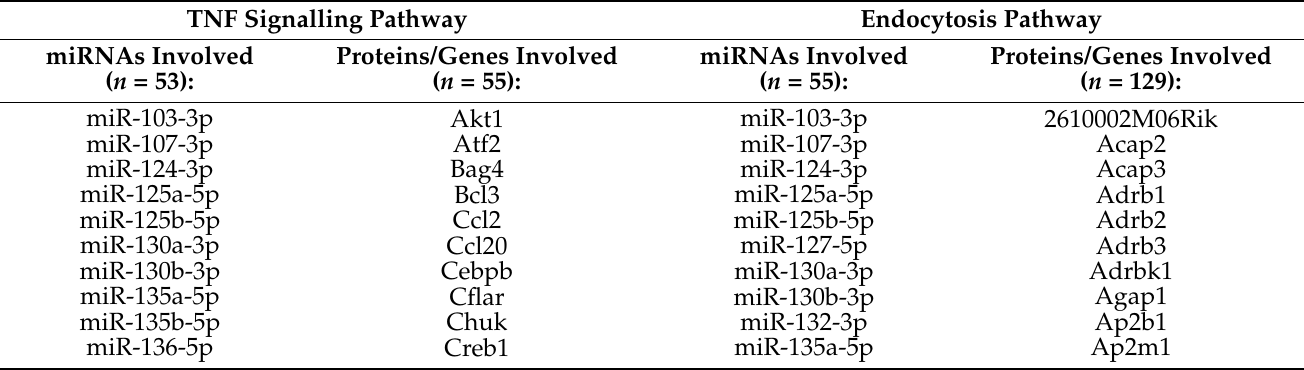
Table 4. miRNAs and proteins implicated in the Endocytosis and TNF signalling KEGG pathways. TNF Signalling